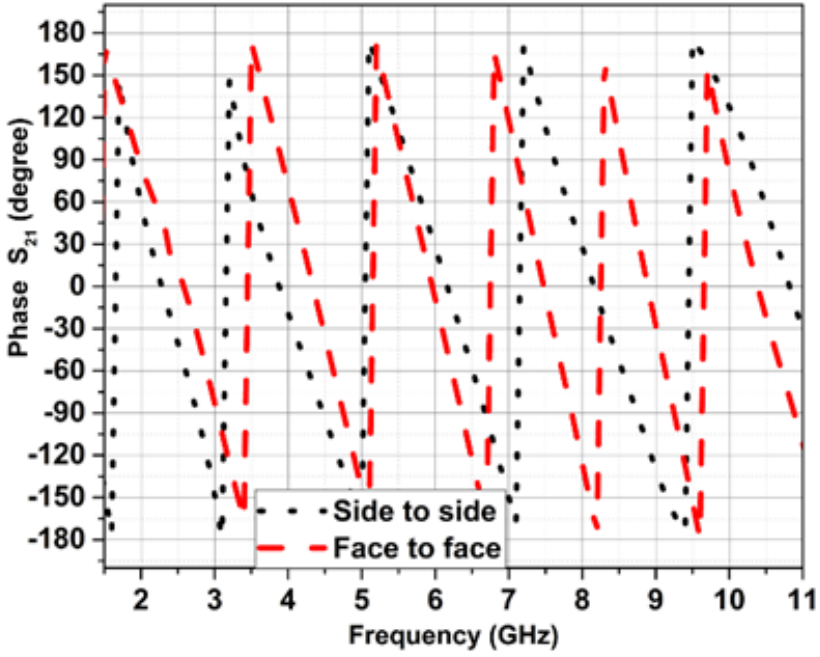
Figure 15. Phase response S 21 of the proposed UWB design.